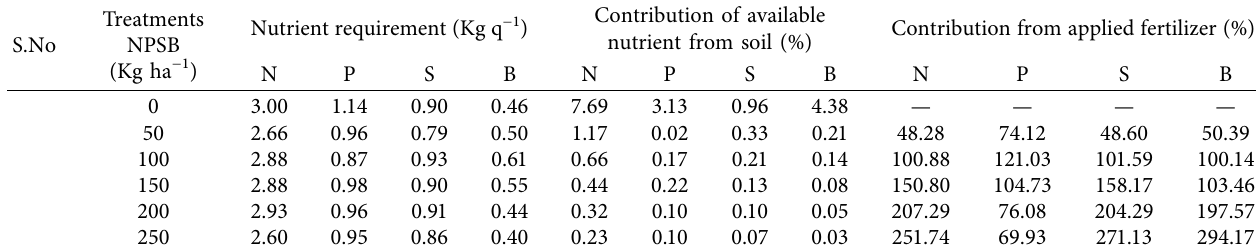
Table 4: Basic data for computing fertilizer dose for targeted yields of awassa dume common bean variety at Meskan District, Gurage zone, Southern Ethiopia. S.No